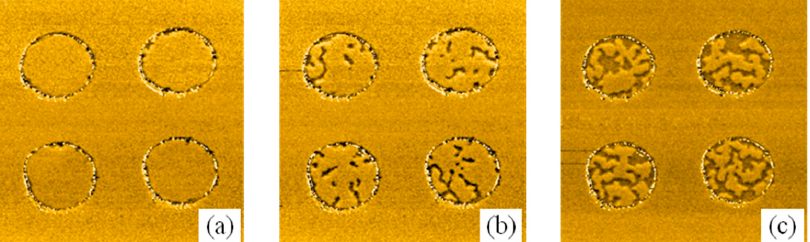
Figure 3. The sequential MFM images of first stage of magnetization reversal for Co/Pt sample with Co (1.5 nm) discs. ( a ) Initial state; ( b ) The remanent state after applying a 100 Oe reversed magnetic field; ( c ) The state after applying a 150 Oe magnetic field. The MFM frame size is 7 μ m × 7 μ m. The MFM contrast is normalized to the maximum.